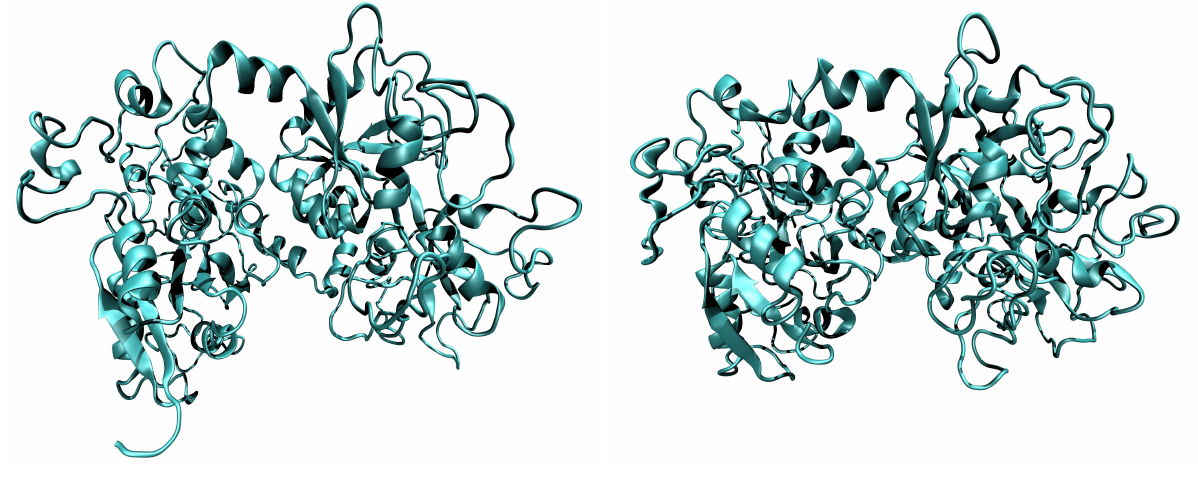
Figure 3. Snapshots of lactoferrin protein in its open ( a ) and closed ( b )